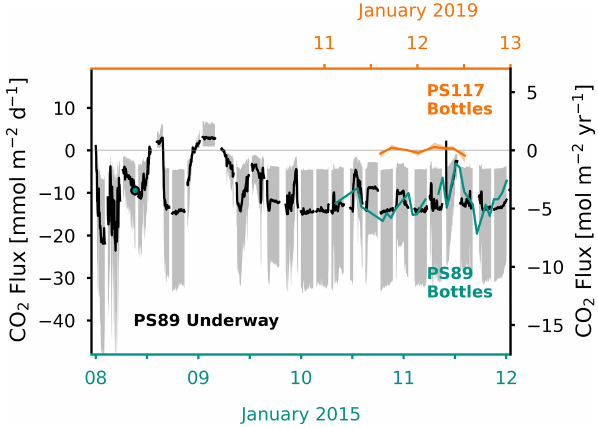
Figure 8. Air–sea CO 2 flux (in mmolm − 2 d − 1 on the left y axis and in molm − 2 yr − 1 on the right y axis) determined from the discrete surface seawater sample measurements and average wind speed for the PS89 (green, bottom x axis) and PS117 (orange, top x axis) tidal observation periods and from the PS89 underway f CO 2 mea- surements (black, bottom x axis), which started on 7 January 2015. The CO 2 flux based on a discrete surface seawater sample collected on 7 January 2015 is also shown with a green marker. The filled shading indicates the range of the flux calculated using the mini- mum and maximum wind speed measured during PS89 and PS117, respectively (Table 1). Negative flux represents CO 2 uptake by the